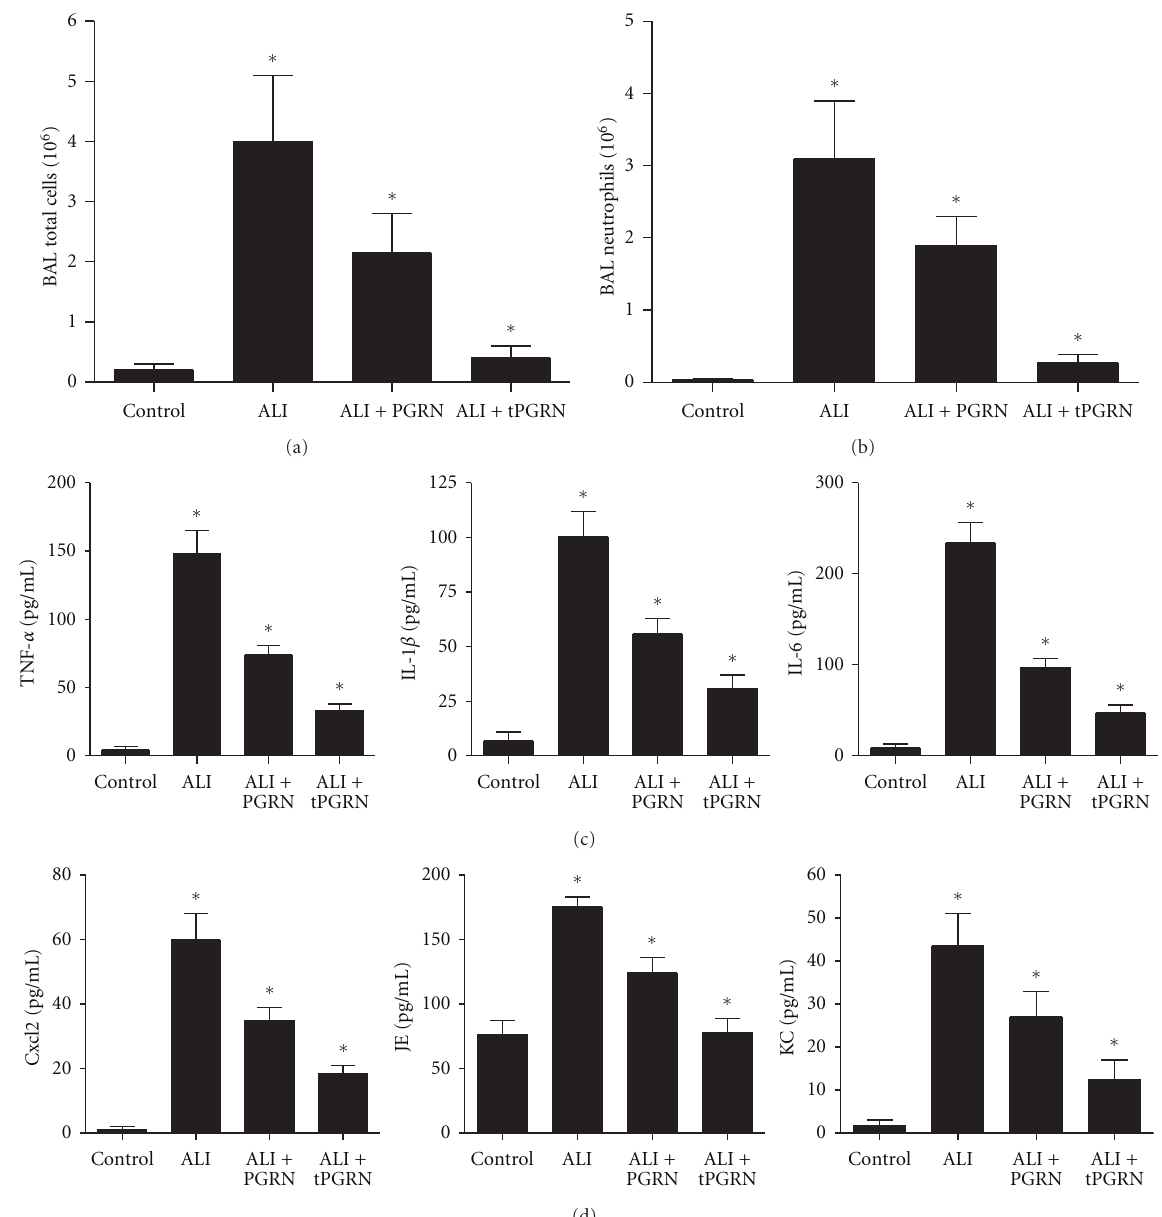
Figure 3: Administration of PGRN attenuated LPS-induced pulmonary inflammation. Groups of mice were challenged with LPS and treated with PGRN 30 min later. The tPGRN represented that PGRN was administered twice at 40 h intervals. (a-b) Total cell (a) and neutrophil (b) counts in BAL fluid were detected to evaluate lung airspace inflammation at day 3 after LPS challenge. (c and d) The indicated proinflammatory cytokines and chemokines in BAL fluid were determined at day 3 after LPS challenge. Data are represented as mean ± standard deviation of one experiment consisting of three replicates. Experiments were performed in triplicate. ∗ P < 0 .